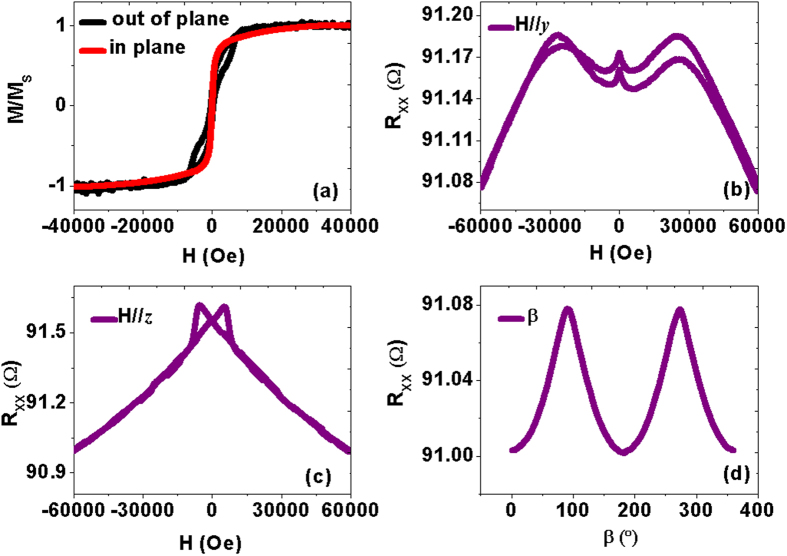
The magnetic and transport properties of MnGa/Pt(1.5)/CoFe/Pt(1.5).(a) The normalized out-of-plane and in-plane magnetic hysteresis loops; (b,c) The field dependent RXX with H along the yand zdirections respectively; (d) β dependence of RXX with a magnetic field of 6 T.